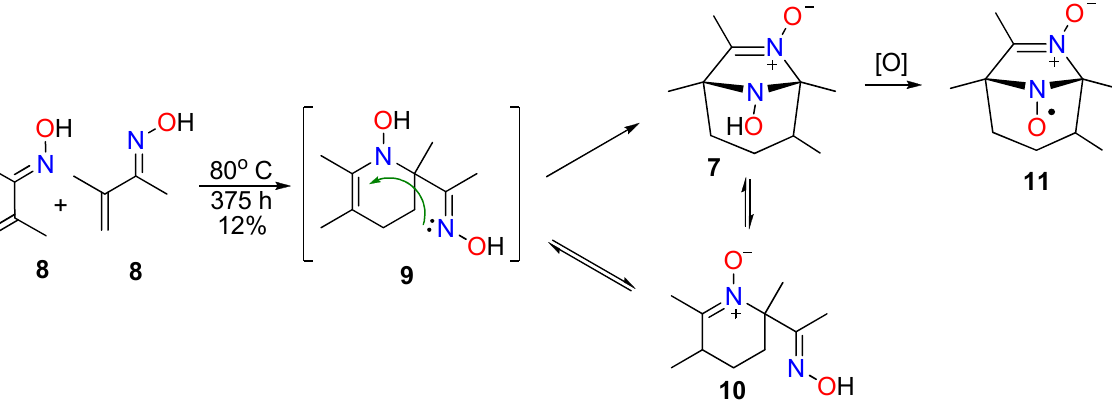
Scheme 2. Formation of 8-hydroxy-1,4,5,7-tetramethyl-6,8-diazabicyclo[3.2.1]oct-6-ene 6-oxide 7 via cyclodimerization of unsaturated oxime 8 .